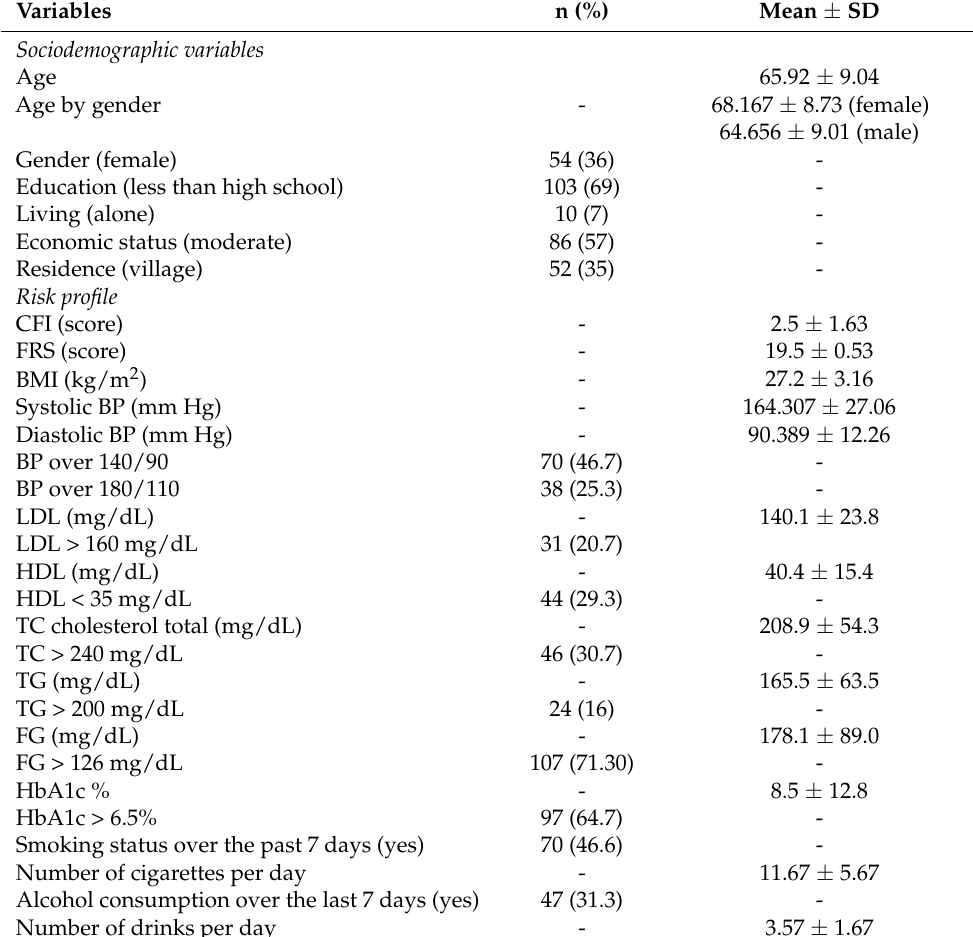
Table 1. Sociodemographic characteristics and risk profile of stroke